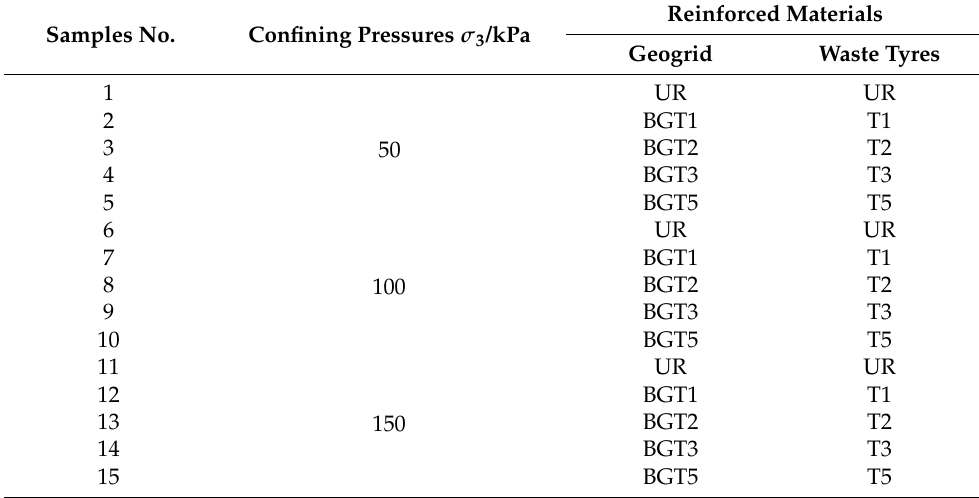
Table 4. Design program for static triaxial